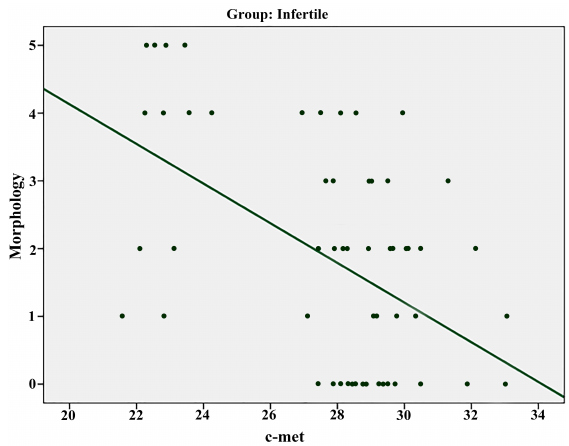
Fig. 5. Negative correlation between sperm morphology per- centage and c-Met expression level in the Infertile group (r = –0.422, p =